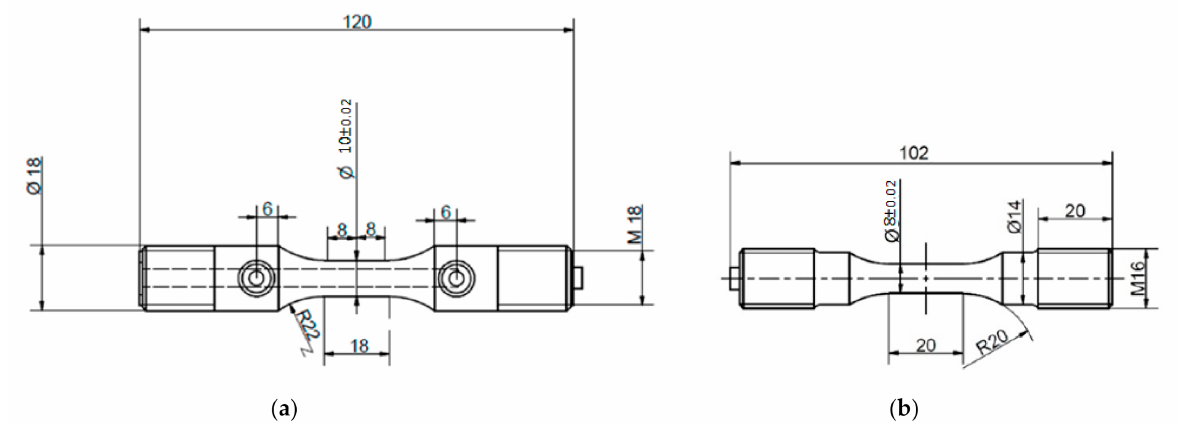
Figure 2. Specimen design of the: ( a ) hollow specimen; ( b ) solid specimen (scale in mm). For the hollow specimens, the roughness of the inner surface is R a = 0.2 µ m. For solid specimens, the roughness is R a = 0.04 µ m. In this case, all principal cracks that led to a final rupture were initiated from the inner